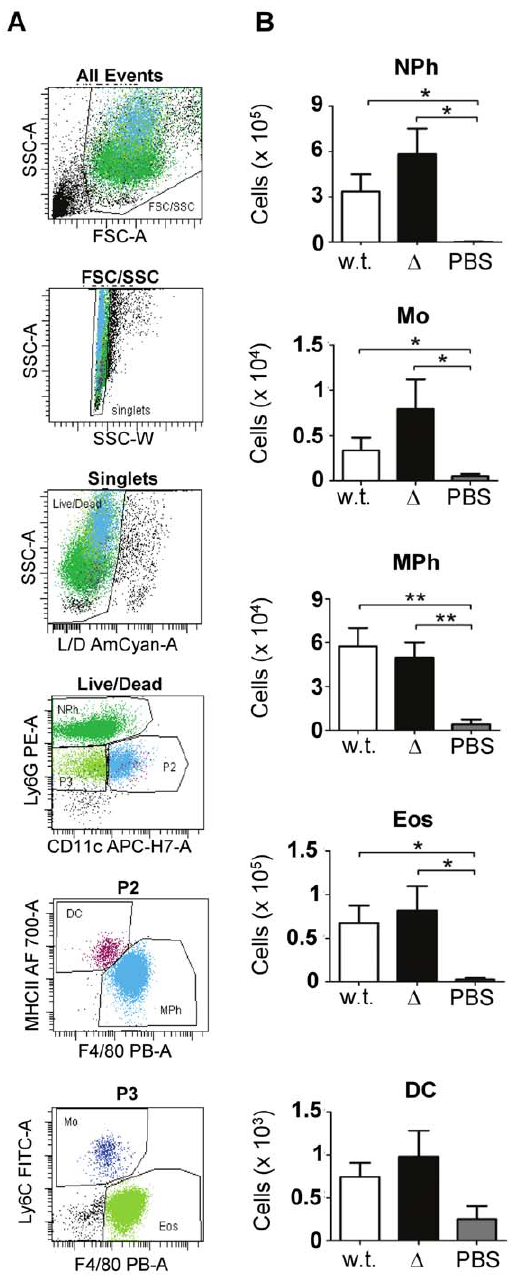
Figure 3. Cell recruitment insitu . ( A ) Gating strategy to identify neutrophils (NPh; Ly6G high , GR1 high ), dendritic cells (DC; CD11c + , MHC- II + ), macrophages (MPh; CD11b + , F4/80 high ), monocytes (Mo; CD11b high , CD11c 2 , Ly6C high , GR1 + ) and eosinophils (Eos; Ly6G int , F4/80 int , SSC high ) 4 h post-infection. ( B ) Counts of each cell population identified in the lavage 4 h post-infection with 3348 (w.t.), 3348 D spyCEP ( D ) or PBS. Data shown are means plus SEM of one representative experiment using 8 mice per group, except for the PBS control (n=3). Statistical significance was tested by Mann-Whitney U: P , 0.05 (*), P , 0.01 (**).